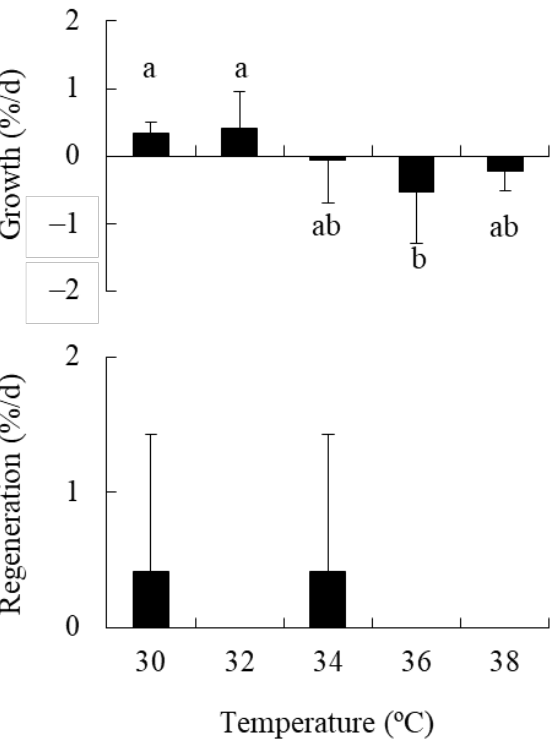
Figure 3. Relative growth and regeneration rates of Sargassum fusiforme holdfasts cultured in five different temperatures (Mean + SD, n = 6) using SSW as the culture media. Different small letters indicate statistical significance among different temperature treatments ( p < 0.1).